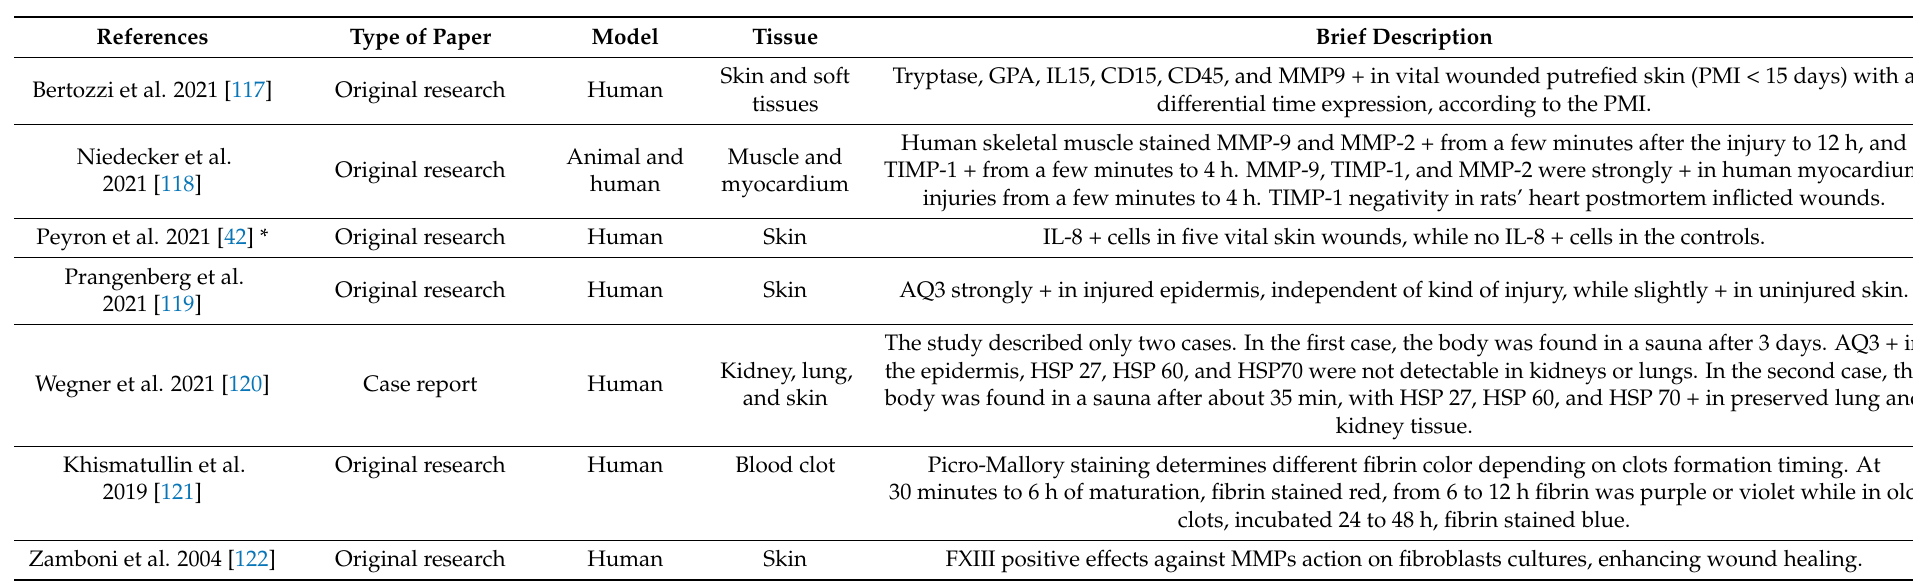
clots, incubated 24 to 48 h, fibrin stained